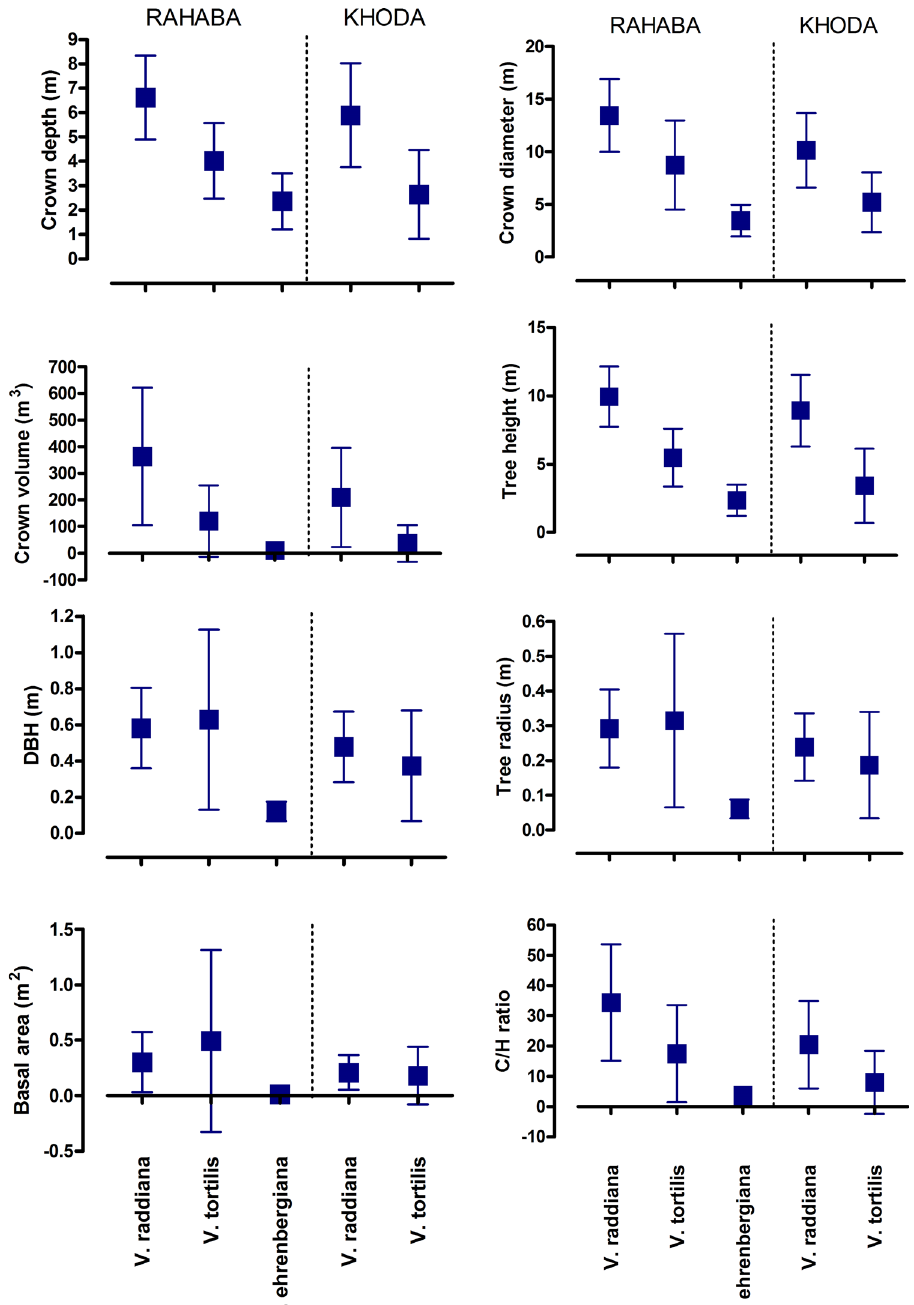
Figure 5. The tree characteristic parameters measured in this study. These parameters included crown depth (m), crown diameter (m), crown volume (m 3 ), tree height (m), diameter at breast height (DBH) (m), tree radius (m), and crown volume/tree height ratio (C/H ratio) for the three Vachellia tree taxa in wadi Khoda and wadi Rahaba, Gebel Elba National Park, south-eastern Egypt. Statistical analyses of these data are provided in the